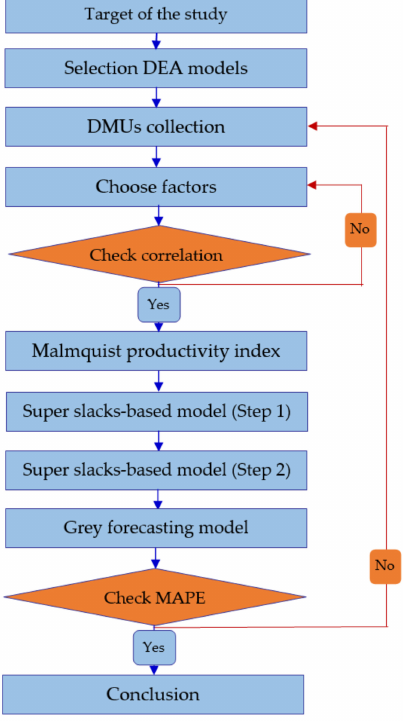
Figure 8. Research process (Source: